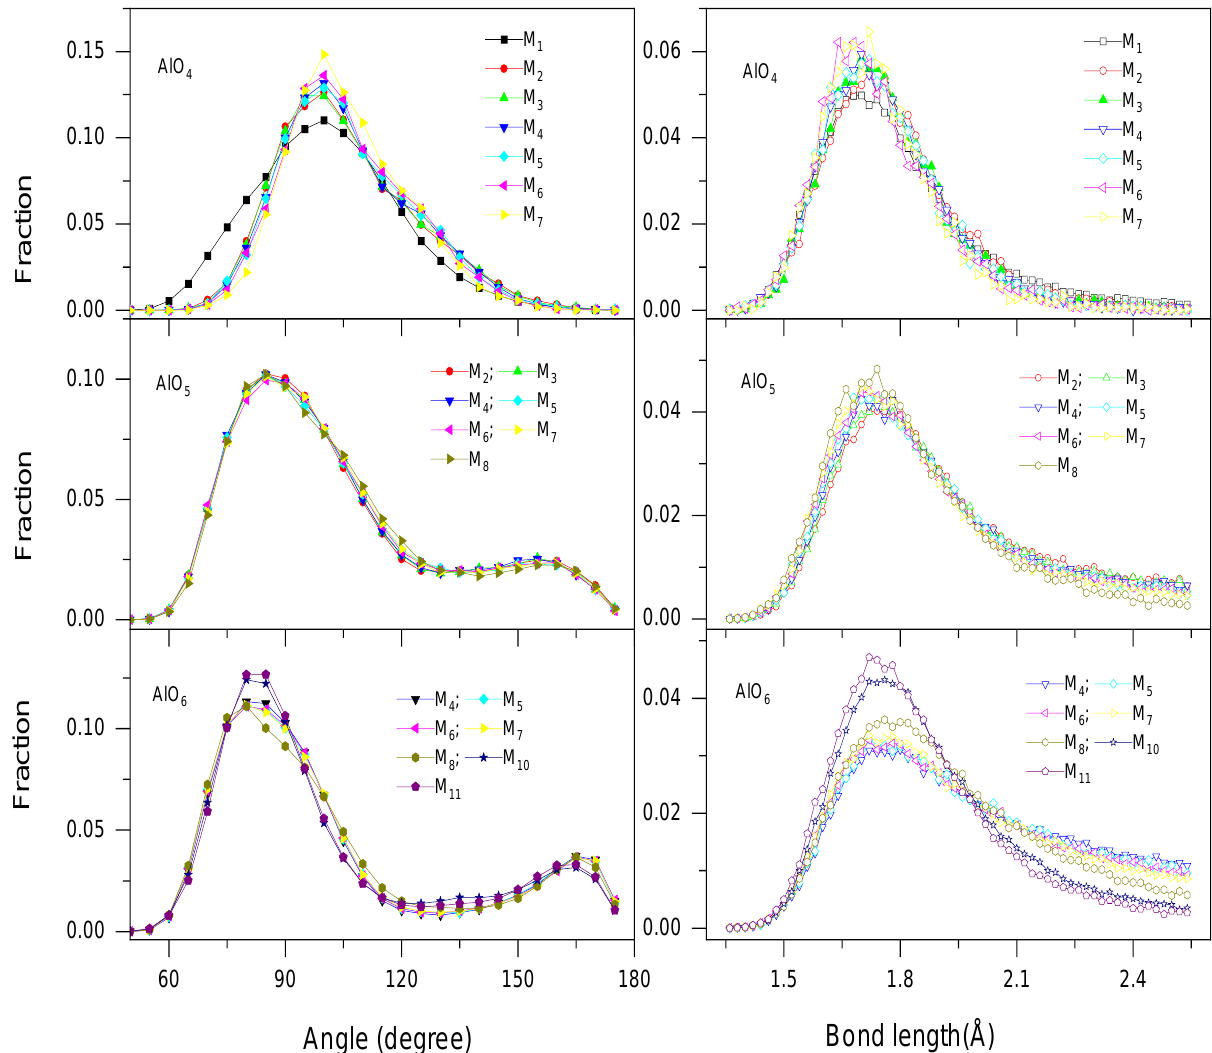
Figure 3. Bond angle O-Al-O (left) and length (right) distribution in coordination units AlO x at different